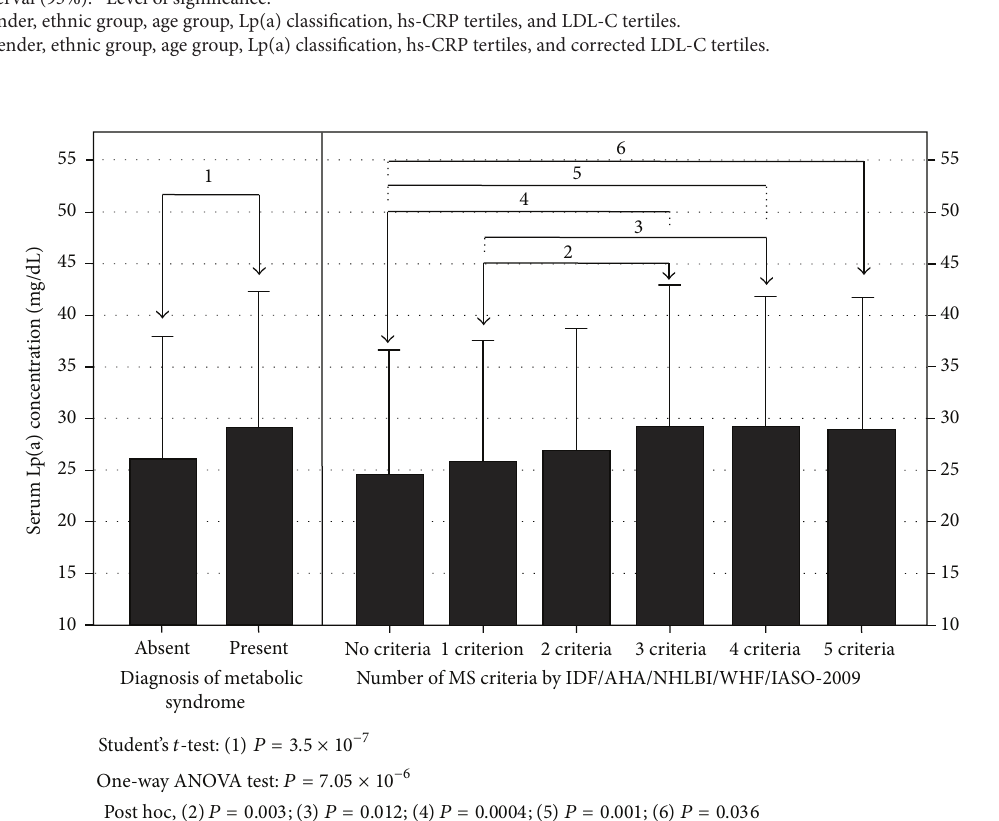
Figure 2: Serum Lp(a) concentration by number of criteria for the metabolic syndrome. The Maracaibo City Metabolic Syndrome Prevalence Study,